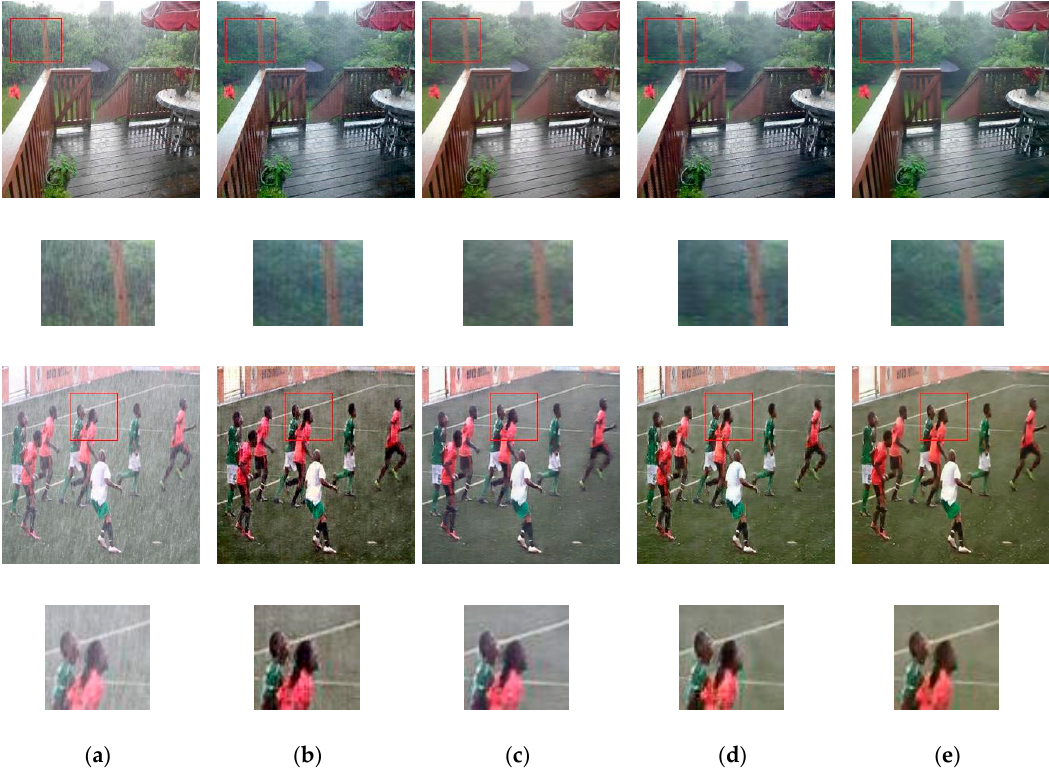
Figure 10. Sample results of real-world rainy images. For good visual comparison, the smaller images below the test images represent specific regions-of-interest. ( a ) input images, ( b ) results of UTN-GAN, ( c ) results of ID-CGAN, ( d ) results of iPANs and ( e ) results of the